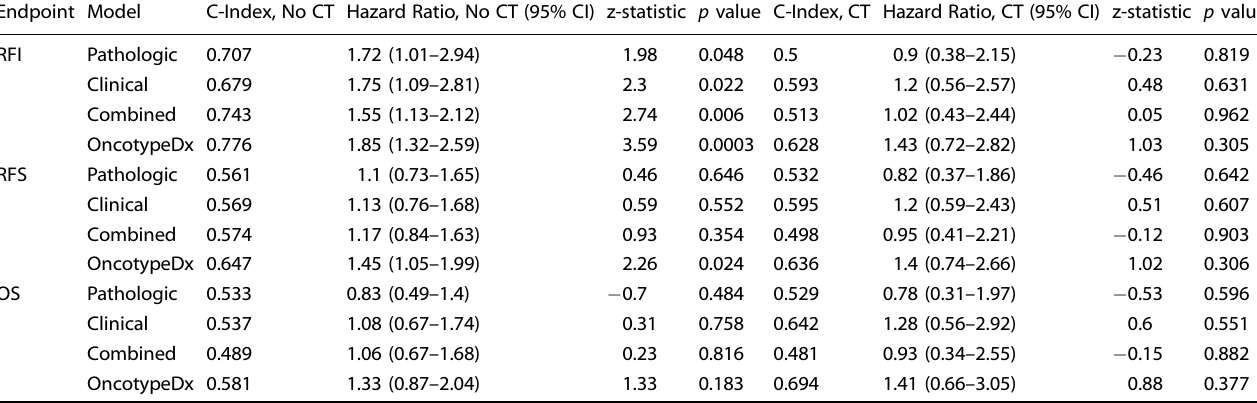
Table 1. Prognostic Value of Models in the Validation